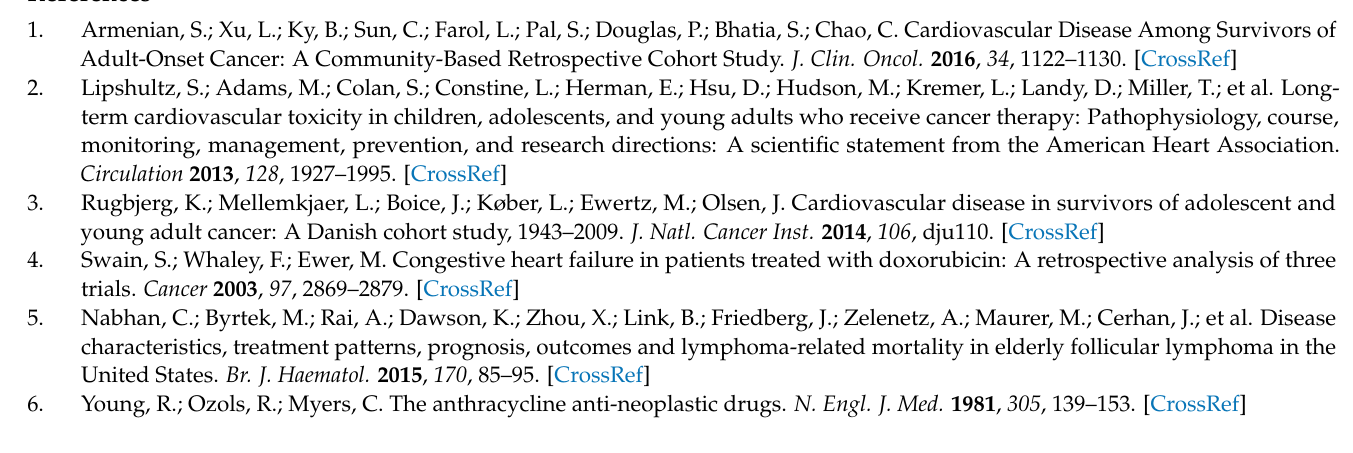
Figure S2: Digital images of catalase mimetic enzyme of CeO 2 @BSA nanoparticles; Figure S3: The effect of DOX on cellular viability; Figure S4: Analysis of the results of hemodynamics through non- invasive monitoring of mice tail; Figure S5: Representative electrocardiography recorded for the mice; Figure S6: Representative electrocardiography recorded for the mice in the four groups and analysis results of the P wave duration, QRS duration, QT interval, and RR interval. Figure S7: Metabolism of CeO 2 @BSA nanoparticles in the heart at different times of the day; Figure S8: Metabolism of CeO 2 @BSA nanoparticles in the major tissues and organs at different times of the week; Figure S9: Body-weight change in CeO 2 @BSA nanoparticles and normal saline